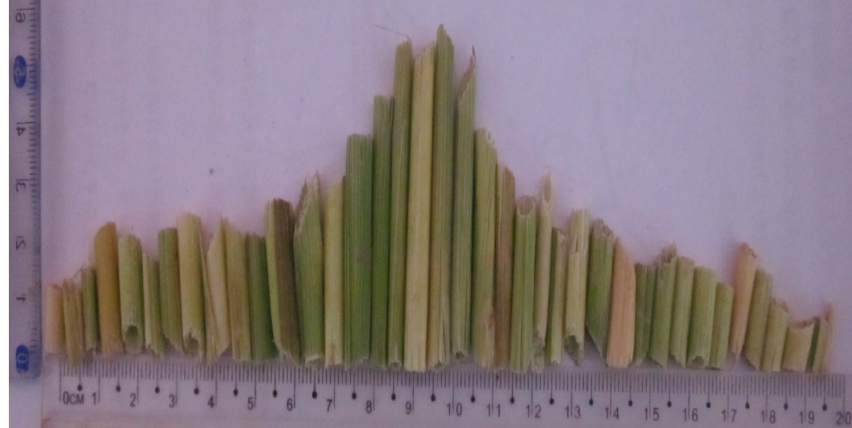
Figure 21: Interval length distribution and distribution of short stems of rice.